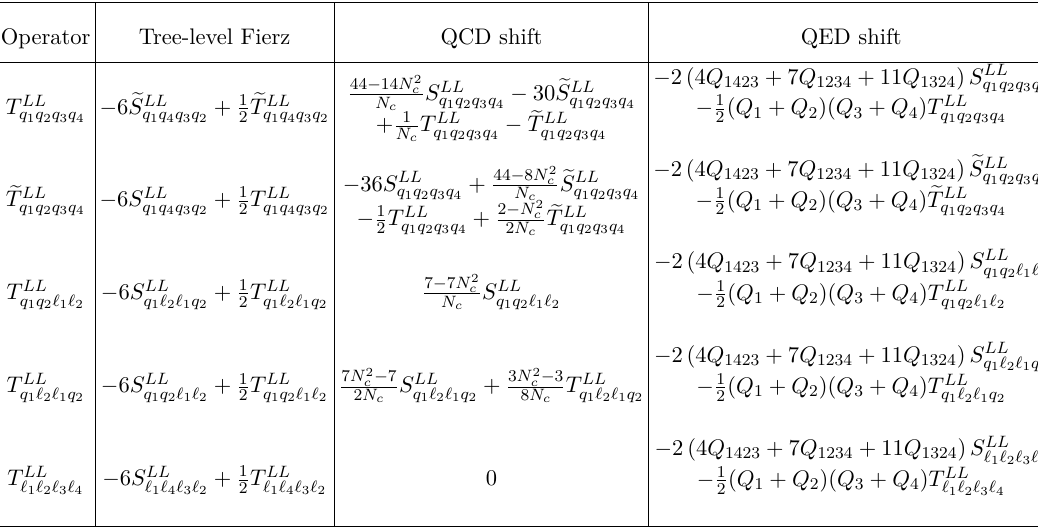
Table 6. Fierz transformations for tensor σ µν P L ⊗ σ µν P L operators together with their one-loop QCD and QED shifts in the original BMU